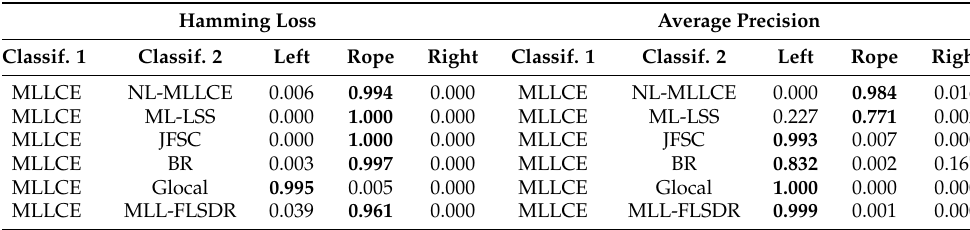
Table 10. Probabilities for the six comparisons of classifiers in terms of One Error and Ranking Loss. Left and right refer to the columns Classif. 1 ( left ) and Classif. 2 ( right ). One Error Ranking Loss Classif. 1 Right MLLCE